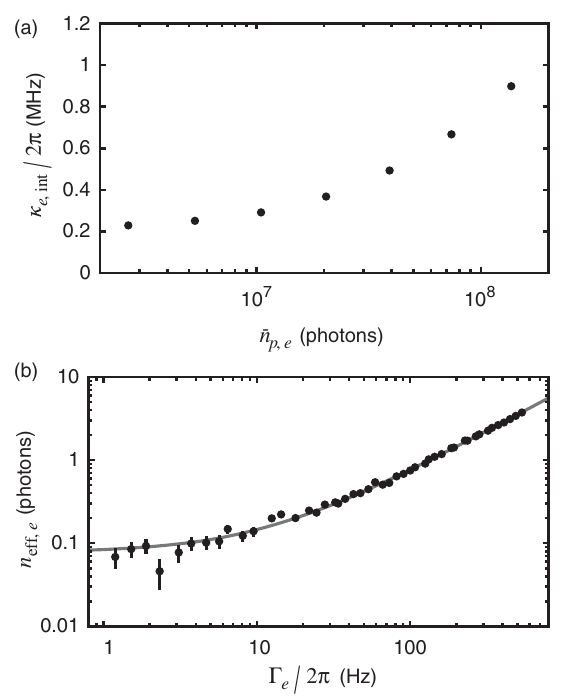
FIG. 10. Microwave pump effects on superconducting circuit. (a) Internal loss of the microwave circuit κ resonator coherent state mean photon number. (b) Effective microwave mode occupancy n , with linear fit. All error bars represent one standard damping Γ e